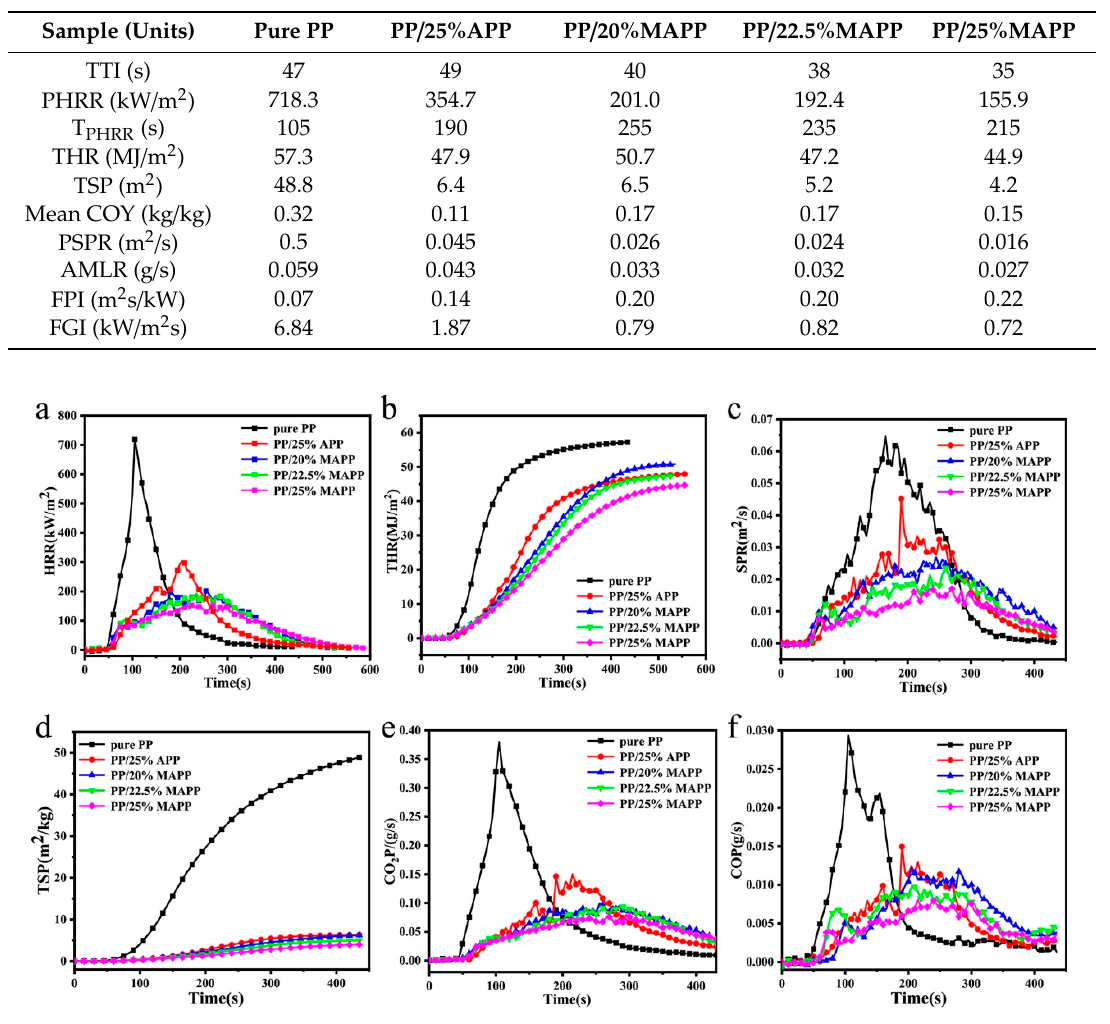
Figure 4. HRR ( a ), THR ( b ), SPR ( c ), TSP ( d ), CO 2 P ( e ), and COP ( f ) curves of samples during the combustion in CCT.